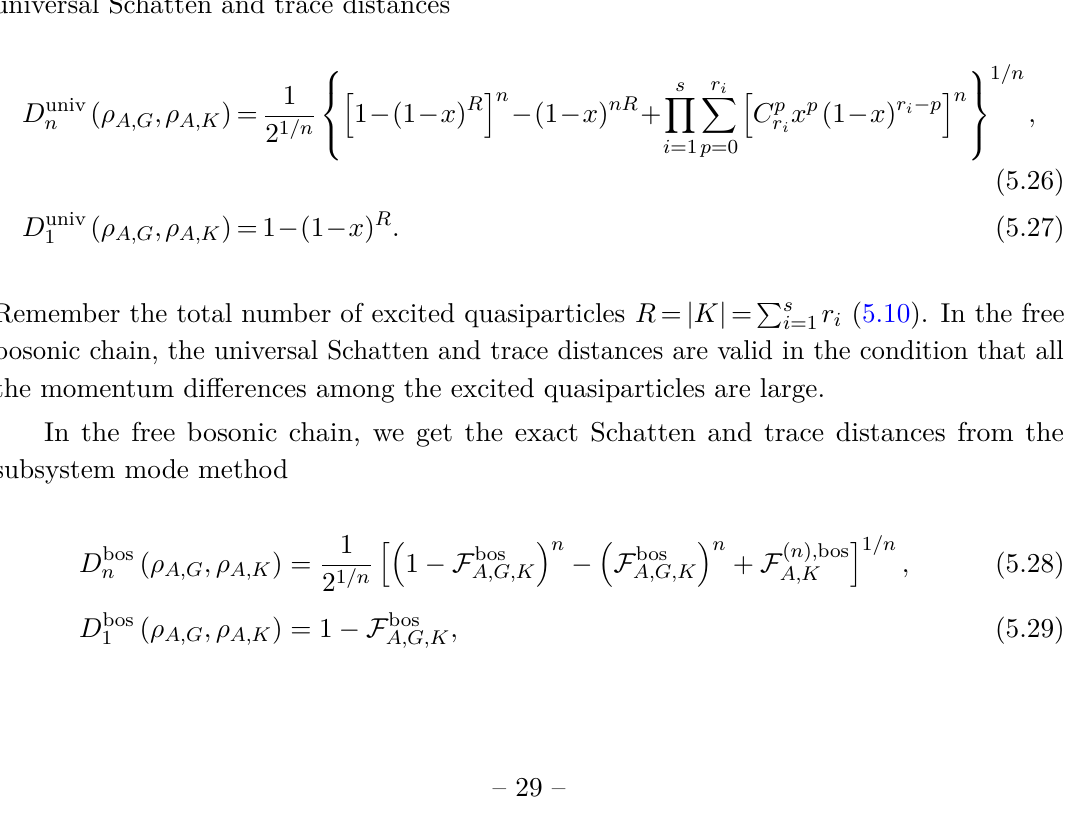
Figure 4 . Examples of the Schatten and trace distances D n ≡ D bos 1 , 2 , 3 , 4 (5.23) and (5.24) and the fidelity F ≡ F bos ( ρ